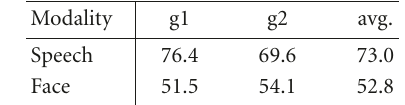
Table 3: Mean reliability estimates for face and speech (in